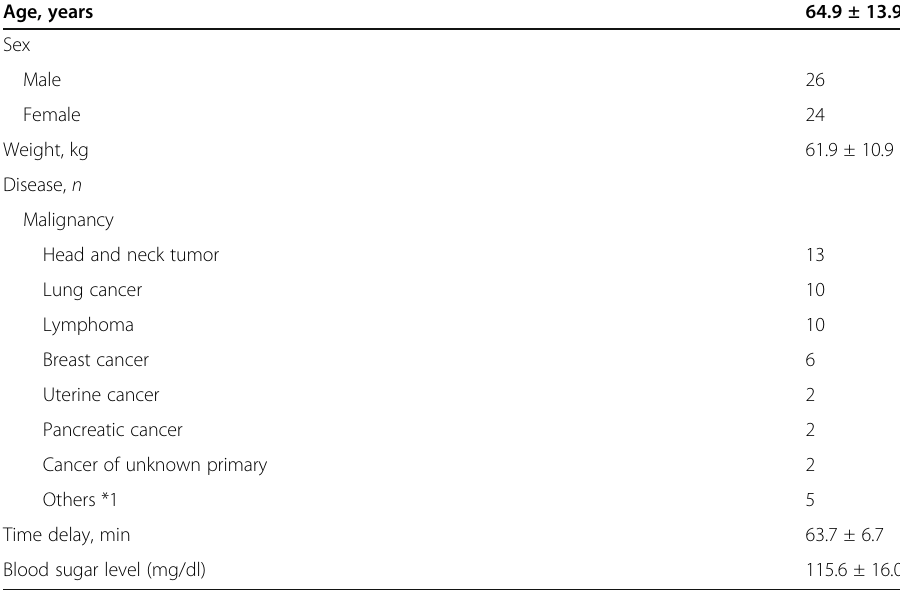
Table 1 Patient demographic and clinical data ( n =